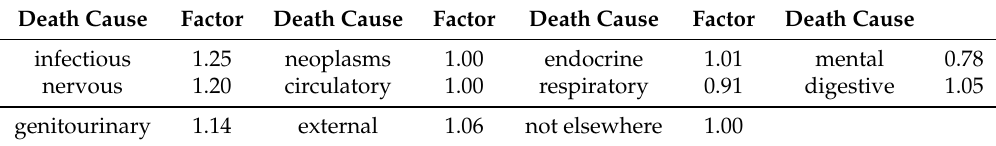
Table 1. Comparability factors for International Classification of Diseases (ICD)-9 to ICD-10. Death Cause Factor Death Cause Factor Death Cause Factor Death Cause infectious 1.25 neoplasms 1.00 endocrine 1.01 mental 0.78 nervous 1.20 circulatory 1.00 respiratory 0.91 digestive 1.05 genitourinary 1.14 external 1.06 not elsewhere